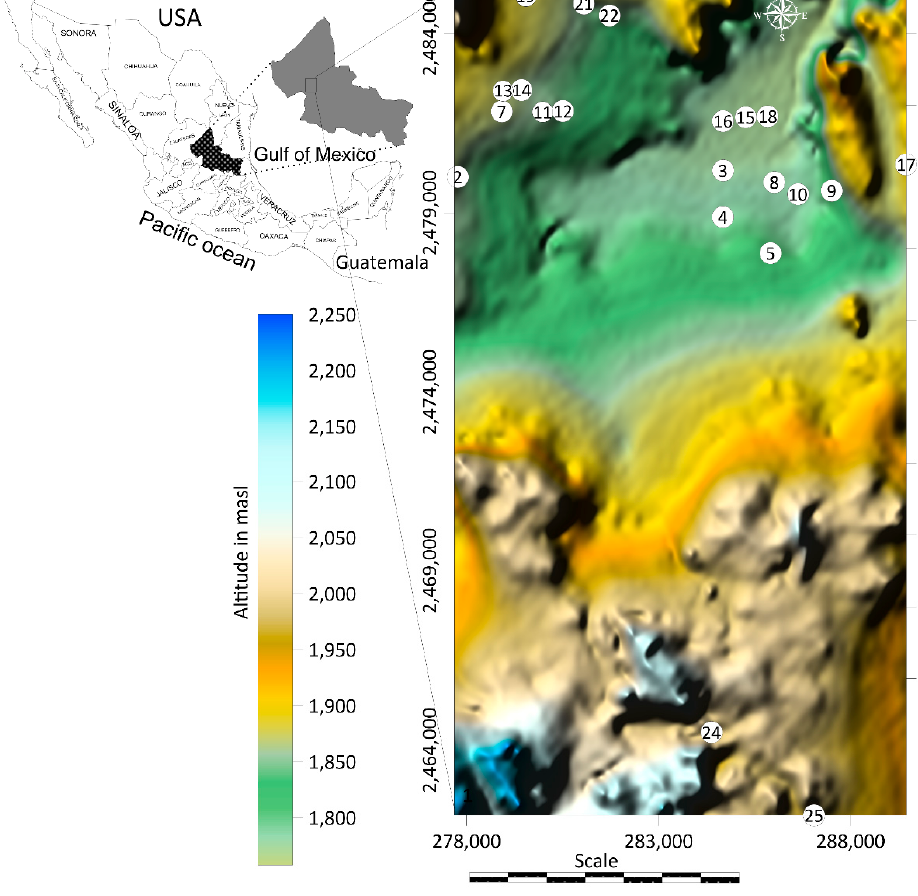
Figure 1. Location of the study area in northeast Mexico, and the locations of the sampling points.